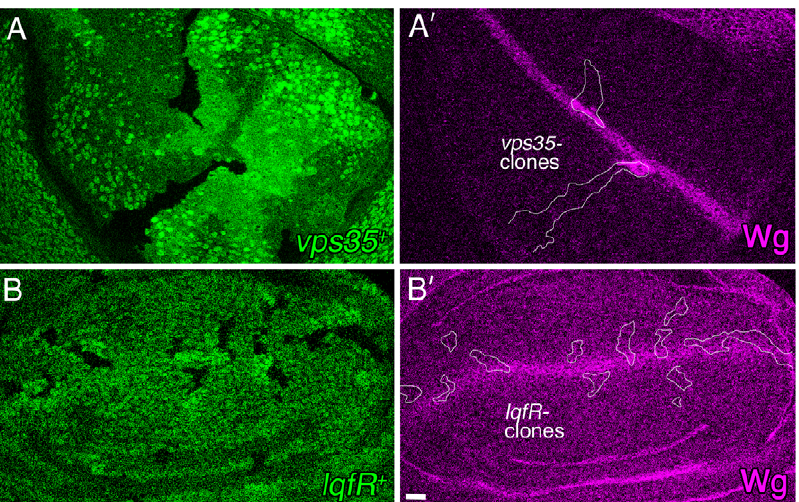
Figure 8. Wg protein secretion in lqfR - clones. Shown are confocal microscope images of two third instar larval wing discs immunostained with Wg antibodies (purple). Wingless is expressed and secreted by a stripe of cells at the dorsal/ventral boundary. Homozygous mutant clones are marked by the absence of GFP (green). (A,A 9 ) A wing disc with vps35 E42 homozygous clones, outlined in white in A 9 . The genotype is hs-flp; FRT42D vps35 E42 /FRT42D ubi-gfp . (B,B 9 ) A wing disc with lqfR D 117 mutant clones, outlined in white in B 9 . The genotype is hs-flp; FRT82B lqfR D 117 /FRT82B ubi-gfp .